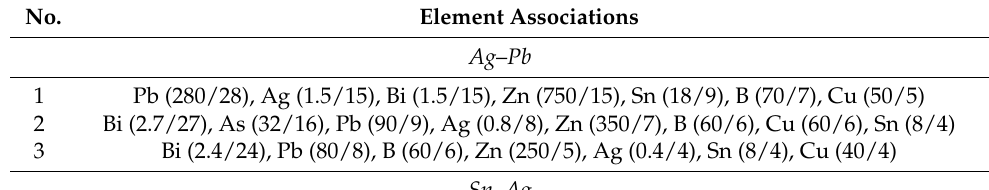
Table 2. The Pestrinsk SBS. Associations of elements (survey of SSs at 1:200,000 scale). No. Element Associations Ag –